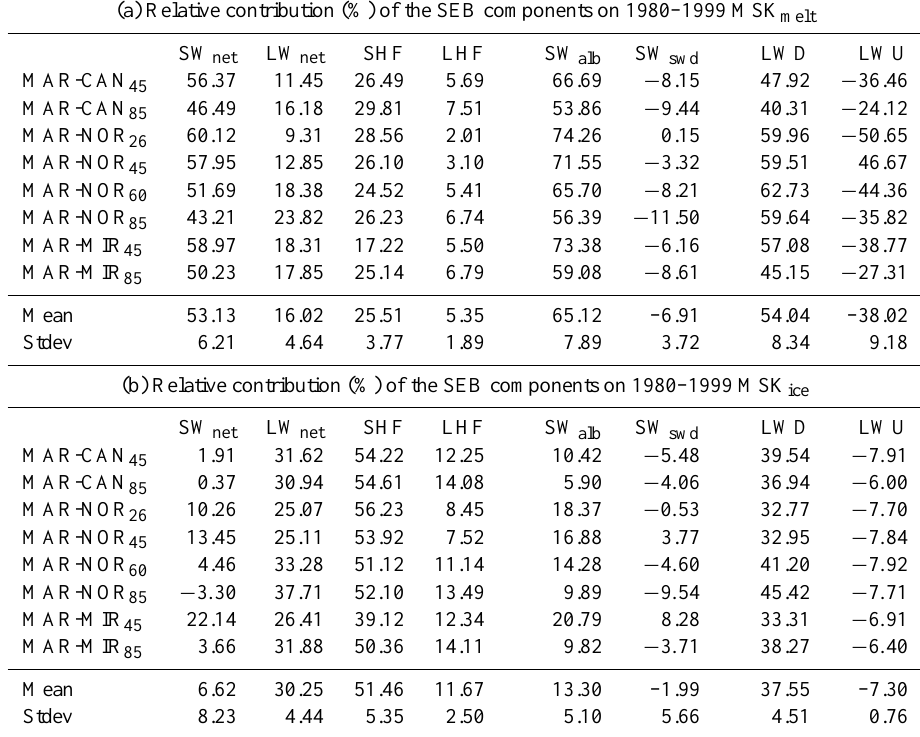
Table 4. (a) Relative contribution (%) of each SEB component to the NET anomalies of the 2080–2099 period compared to the 1980– 1999 period, according to the forcing fields. Each future projection was compared to the 1980–1999 average of the present-day simulation performed with the same GCM as forcing fields, on the related 1980–1999 MSK melt . (b) The same as (a), but on the related 1980–1999 MSK ice